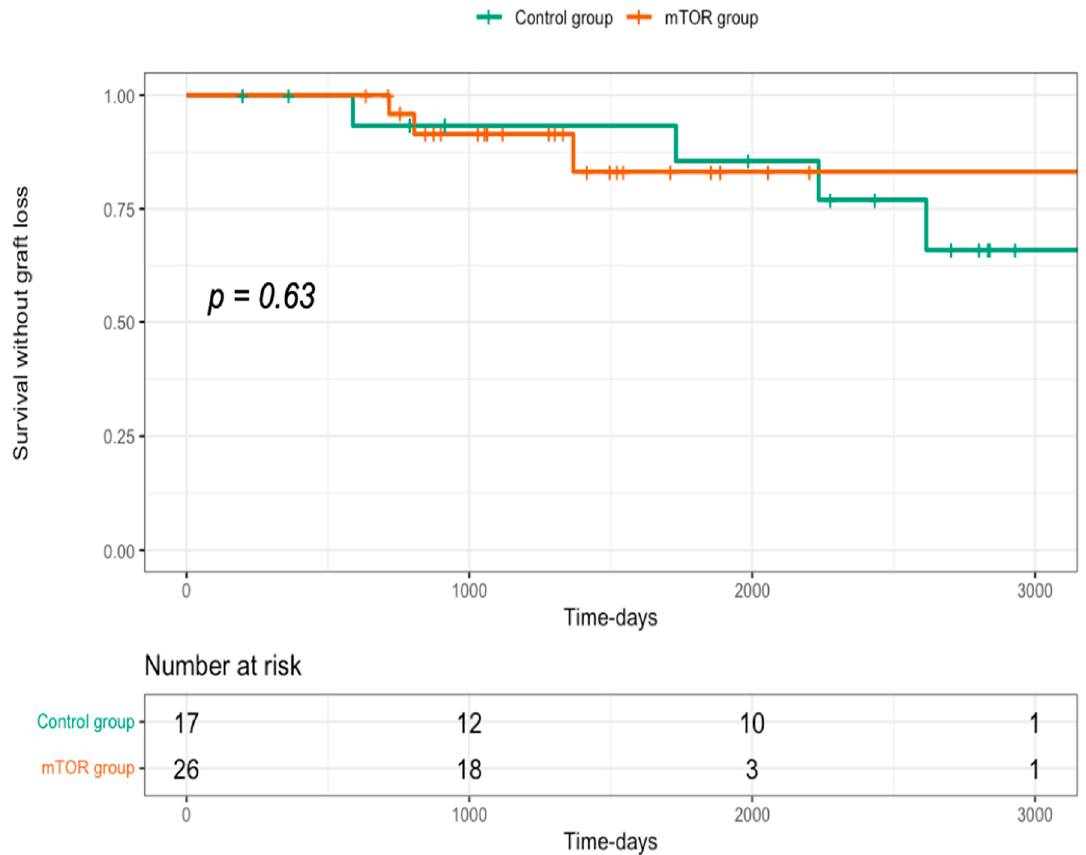
Figure 3. Outcomes of death-censored graft loss (DCGL) according to BKV DNAemia treatment. Kaplan–Meier analysis curve, showing death-censored graft survival rates for patients who received mTORi for BKV DNAemia compared to the control group.